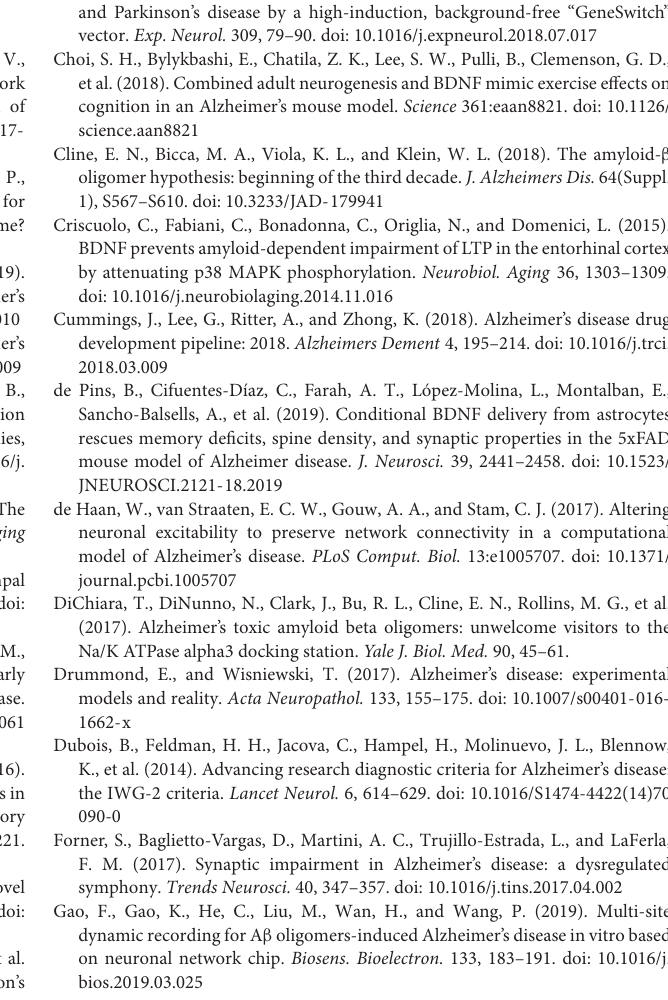
FIGURE S1 | Representative light field images of primary hippocampal cultures obtained from wild-type and 5xFAD murine embryos (DIV 21), Scale bar – 20 µ m. Comparative morphological assessment did not reveal significant changes between cultures obtained from wild-type and 5xFAD murine embryos over 28 DIV. FIGURE S2 | Features of TrkB-FL gene expression on DIV 21 under chronic exogenous administration of A β and BDNF. Data are normalized to the reference gene (Oaz1). The data represent the mean values ± SEMs from three independent experiments. We showed no significant alterations in TrkB-FL mRNA levels in primary hippocampal cultures on DIV21 under chronic A β